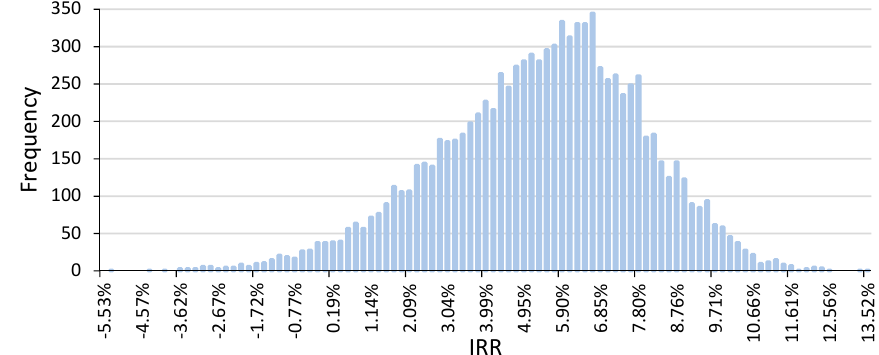
Figure 13. Histogram of the IRR calculated with the Monte Carlo method for a 50 kW system.